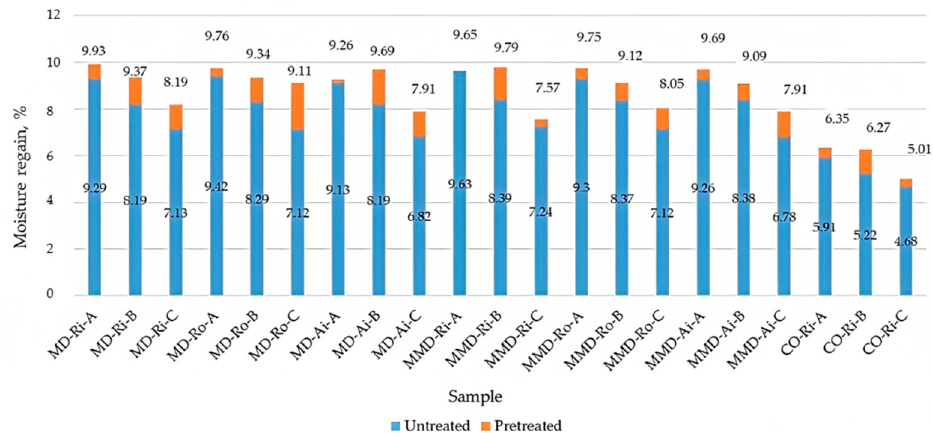
Figure 14. Moisture regain of the untreated and pretreated sock plain knit samples determined before and after five repeated washing and drying cycles of the socks (where MD—modal fibers, MMD—micro modal fibers, CO—cotton fibers; Ri—ring spun yarn, Ro—rotor spun yarn, Ai—air-jet spun yarn; A, B, C—sock group).